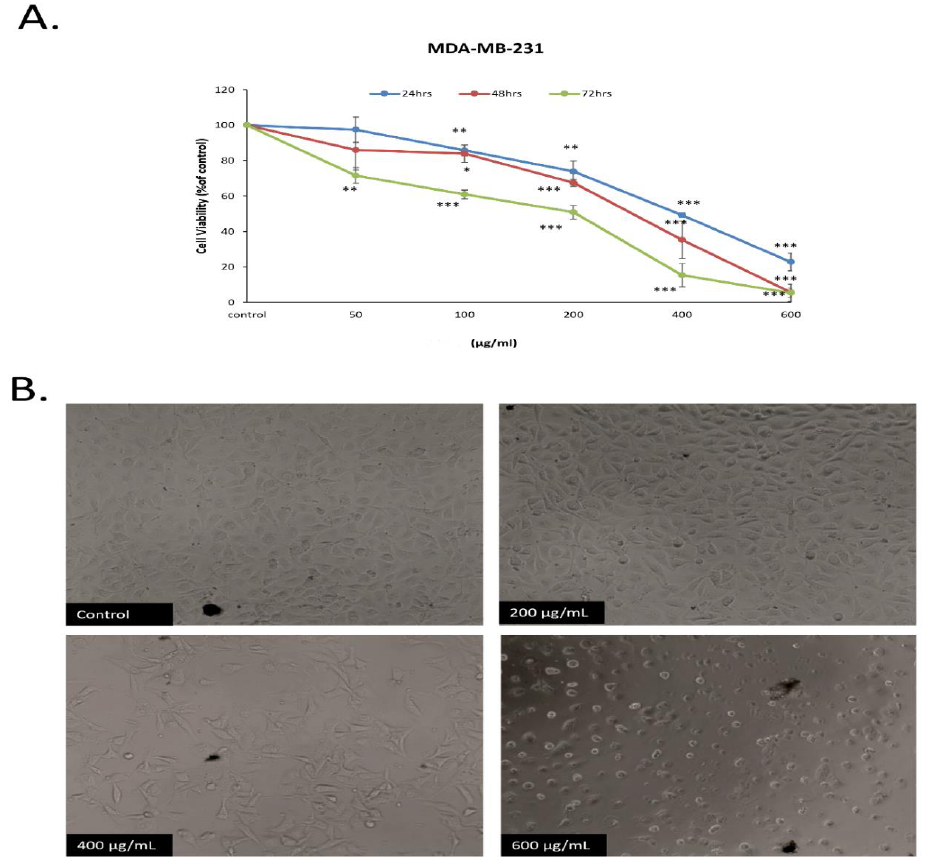
Figure 2. Impact of AME extract on morphological changes and viability of human breast cancer cells MDA-MB-231. ( A ) Cell viability in percentage subsequent to incubation of exponentially proliferating cells with specified concentration level of AME extract and control for 24, 48 and 72 h. ( B ) After 48 h of incubation, the photomicrograph shows the effect of different concentrations of AME extract on MDA-MB-231 cells. The data display the mean of the test as measured in triplicate. (* p = 0.05, ** p = 0.005 and *** p = 0.0005).